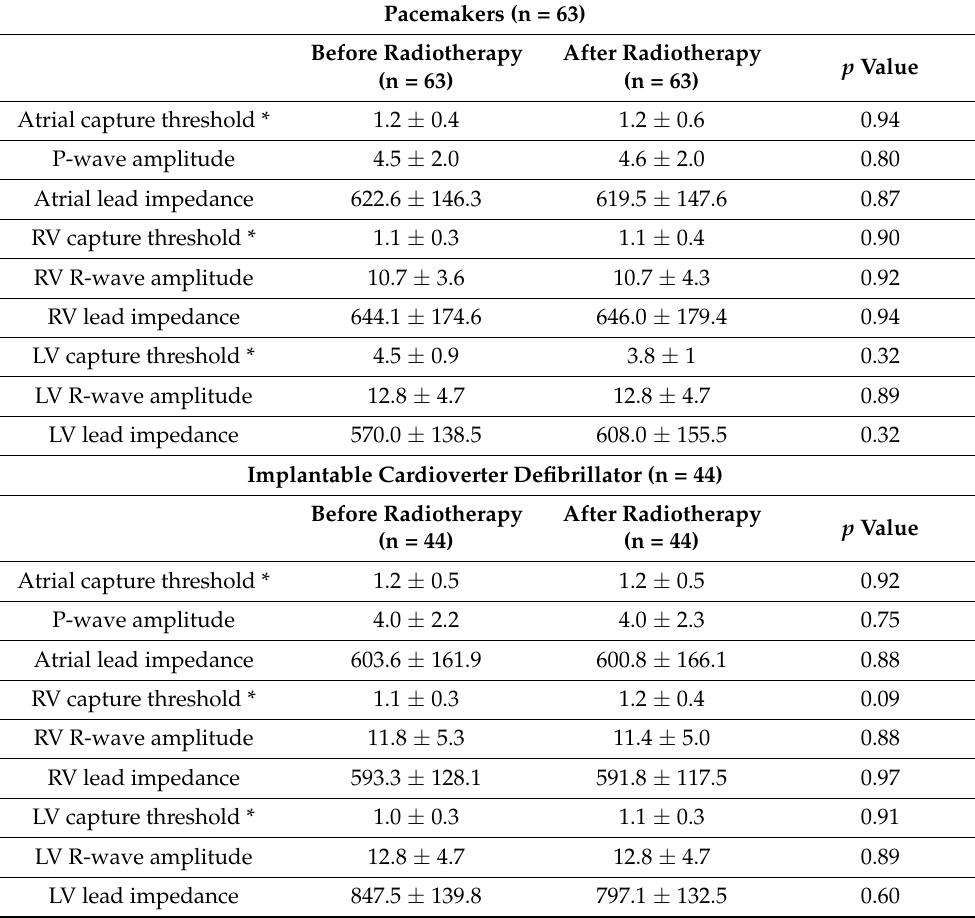
Table 3. Changes in device parameters according to device type.